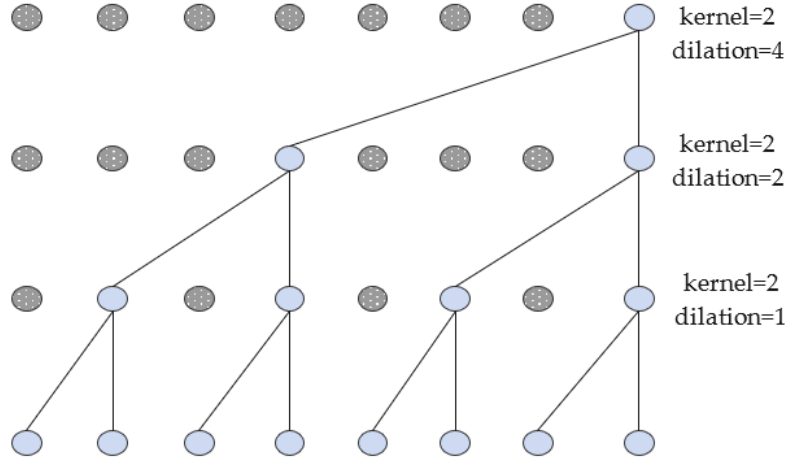
Figure 2. Causal expansion convolution structure diagram.